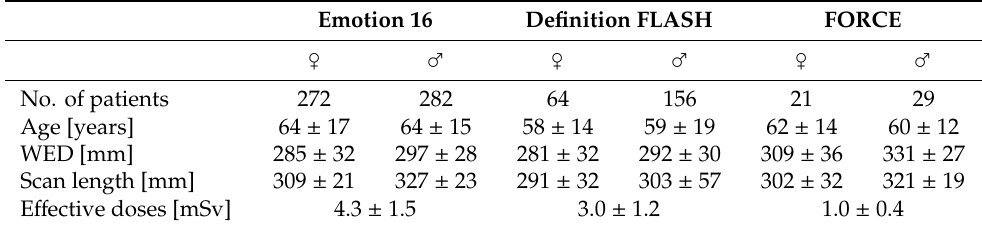
Table 2. Age, water-equivalent diameter (WED), and scan length of the female and male patients examined in inspiration at the three considered CT systems as well as the resulting effective doses.